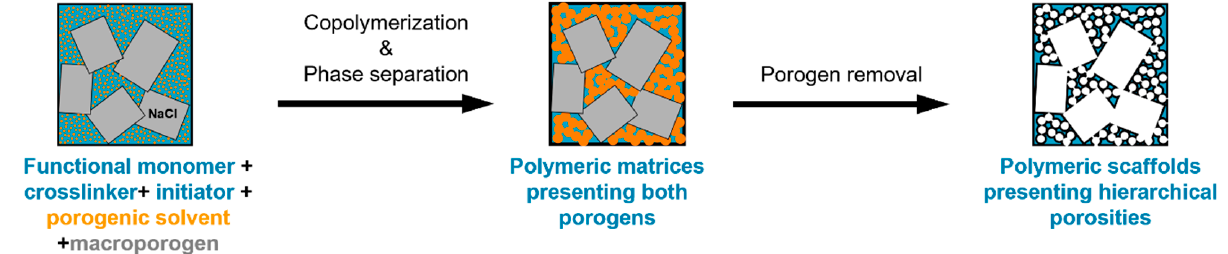
Figure 3. Schematic representation of the double porogen templating approach implemented for the preparation of doubly porous polymers.